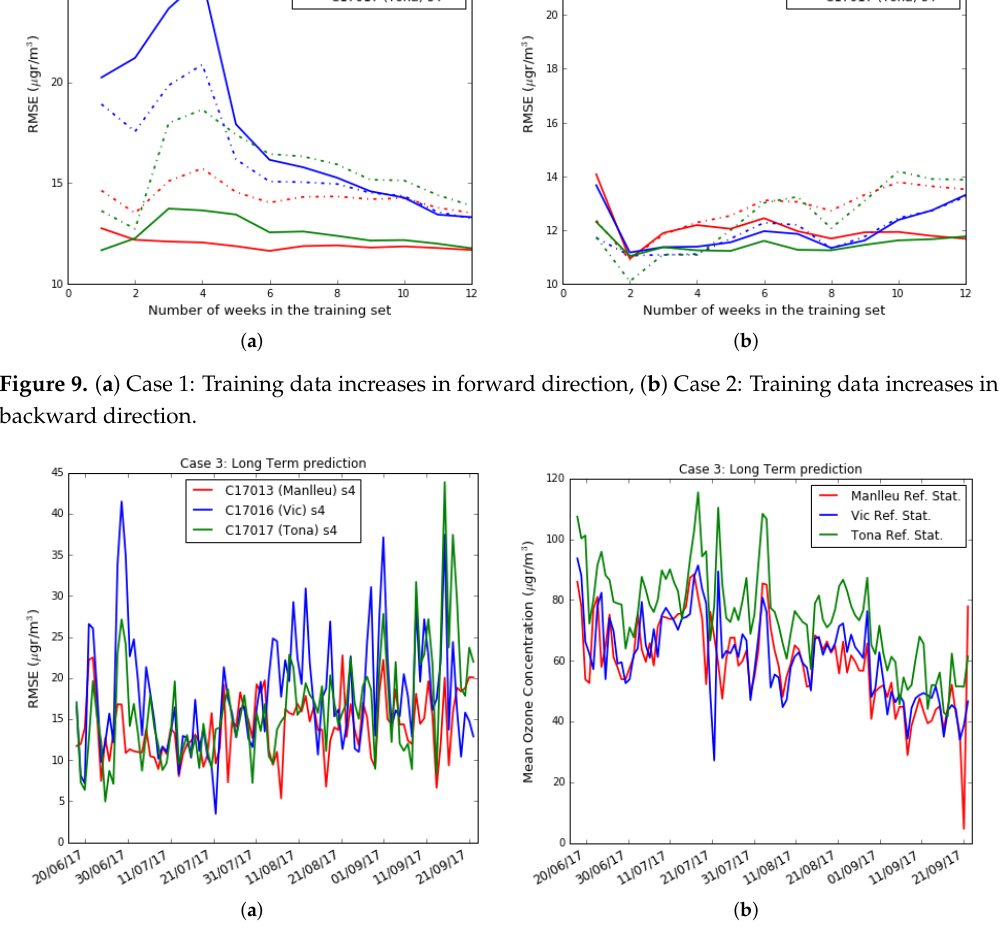
Figure 10. ( a ) Case 3: Captors Test RMSE in per day basis with training set of 3 weeks, ( b ) Case 3: Average ozone ( µ g/m 3 ) in per day basis in the reference